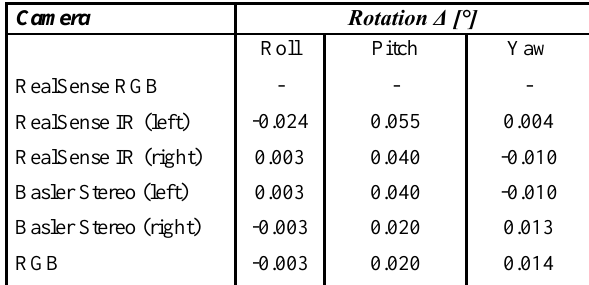
Table 6: Rotation differences of sensor pose comparison between two multi-camera calibration